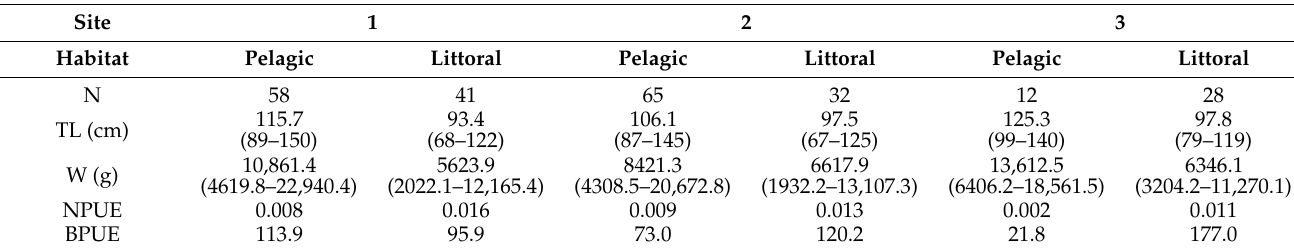
Table 1. Number (NPUE), biomass (BPUE), total length (TL in centimeters) with min–max values, and estimated weight (W in grams) with min–max values of European catfish harvested at each sampling site between the pelagic and littoral compartments. NPUE = number per unit effort (individual/m 2 ); BPUE = biomass per unit effort (grams/m 2 ). Site 1 2 3